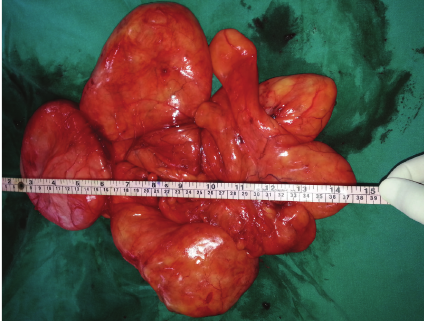
Figure 2: Lipoma after complete